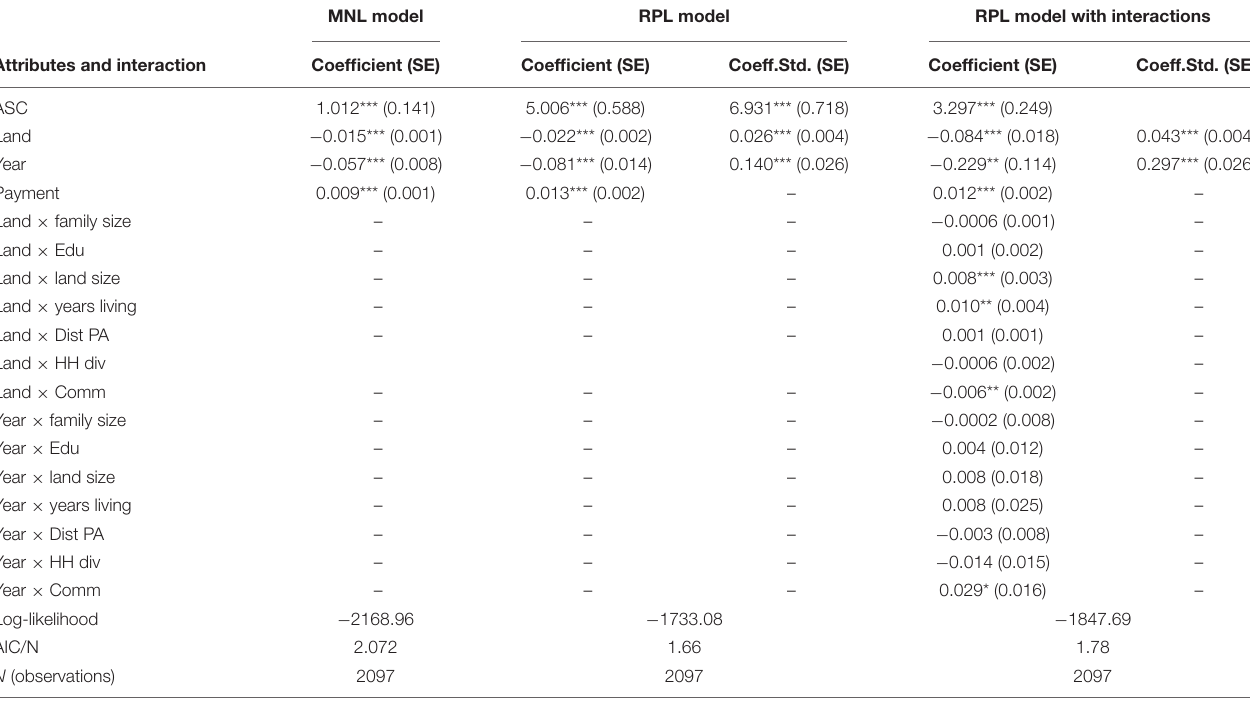
TABLE 3 | Results of the Multinomial Logit (MNL) and Random Parameter Mixed Logit (RPL), estimations, standard errors in